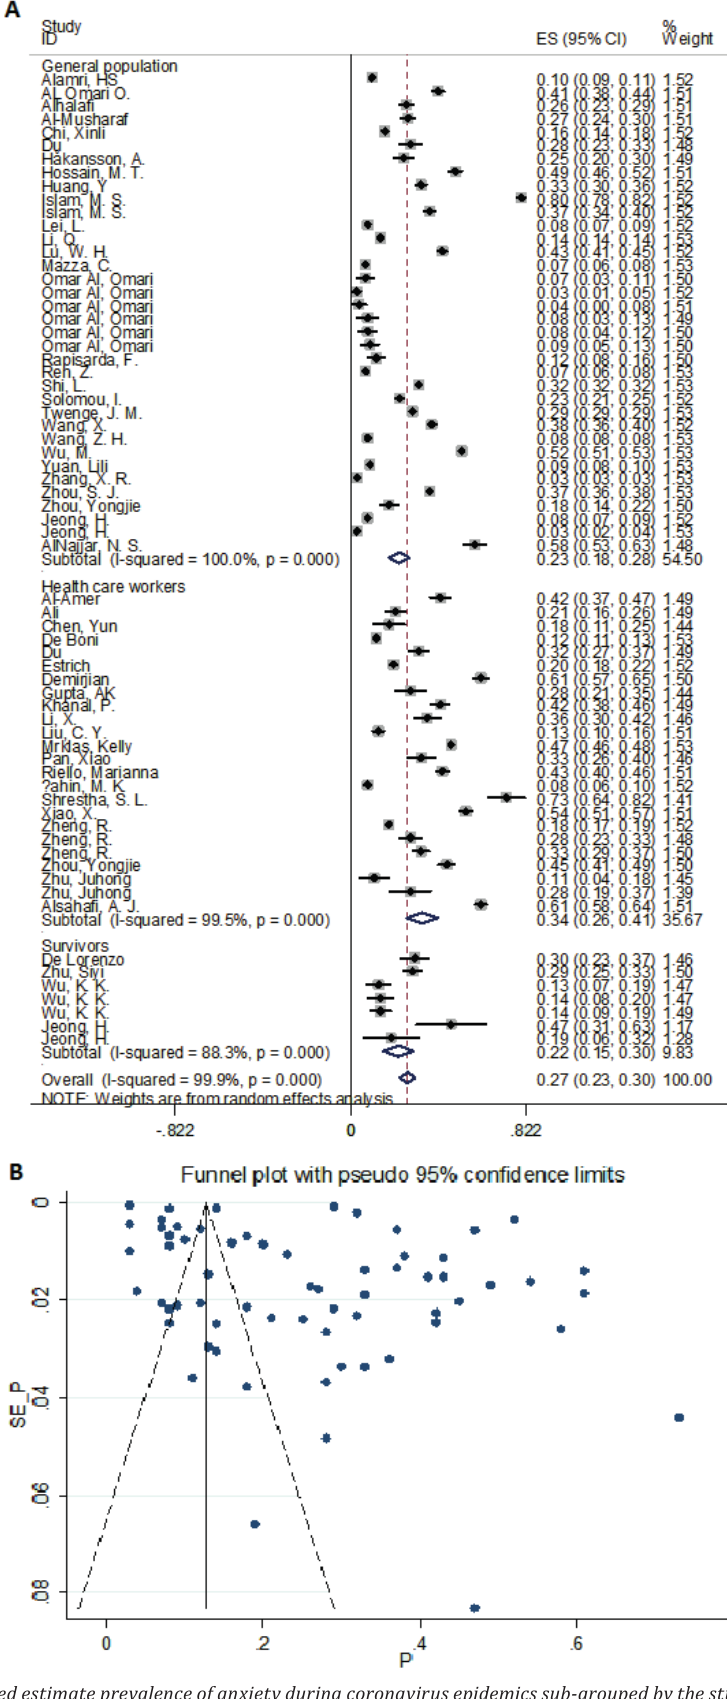
Fig 5. A: Forest plot; Pooled estimate prevalence of anxiety during coronavirus epidemics sub-grouped by the study population. B: Funnel plot; publication bias detected in reporting anxiety during coronavirus epidemics (Egger’s test P-value =